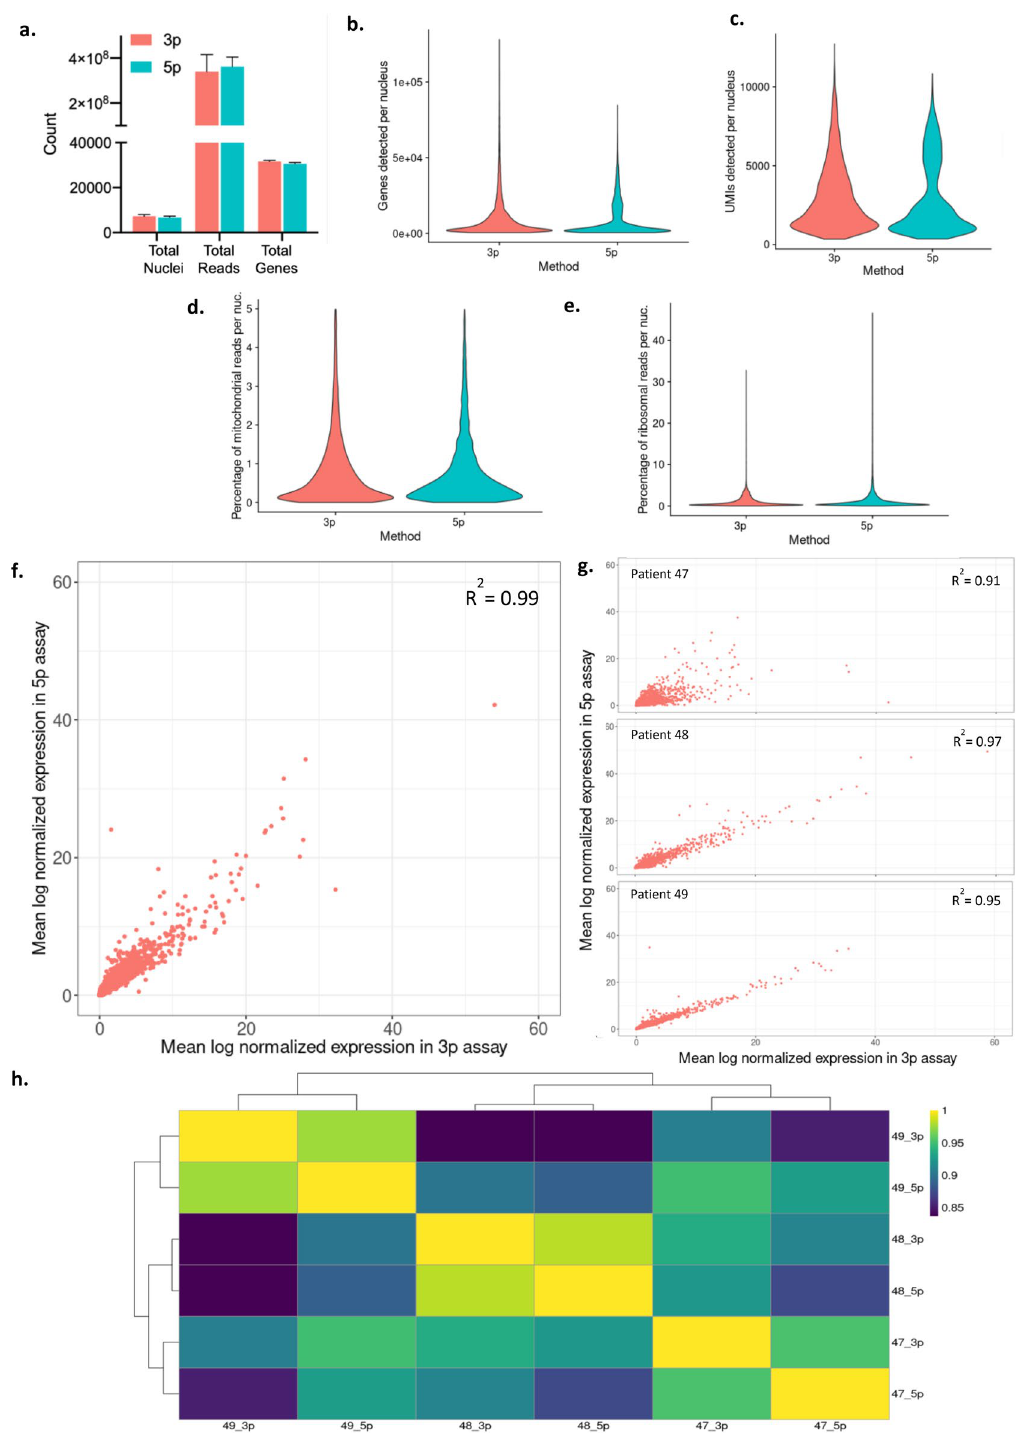
Figure 2. Consistent sensitivity and gene expression across kits. ( a ) 5’ and 3’-RNA-seq libraries were sequenced to similar depth with similar number of nuclei captured. ( b,c ) Number of UMIs and genes detected per nucleus were similar for each kit. ( d,e ) Quality metrics (percent mitochondrial and ribosomal reads per nucleus) were similarly low for each kit. ( f,g ) Mean log-normalized gene expression values were highly correlated by kit both on average and on a per-patient basis. ( h ) Correlation matrix showing high concordance of gene expression in 3’ versus 5’